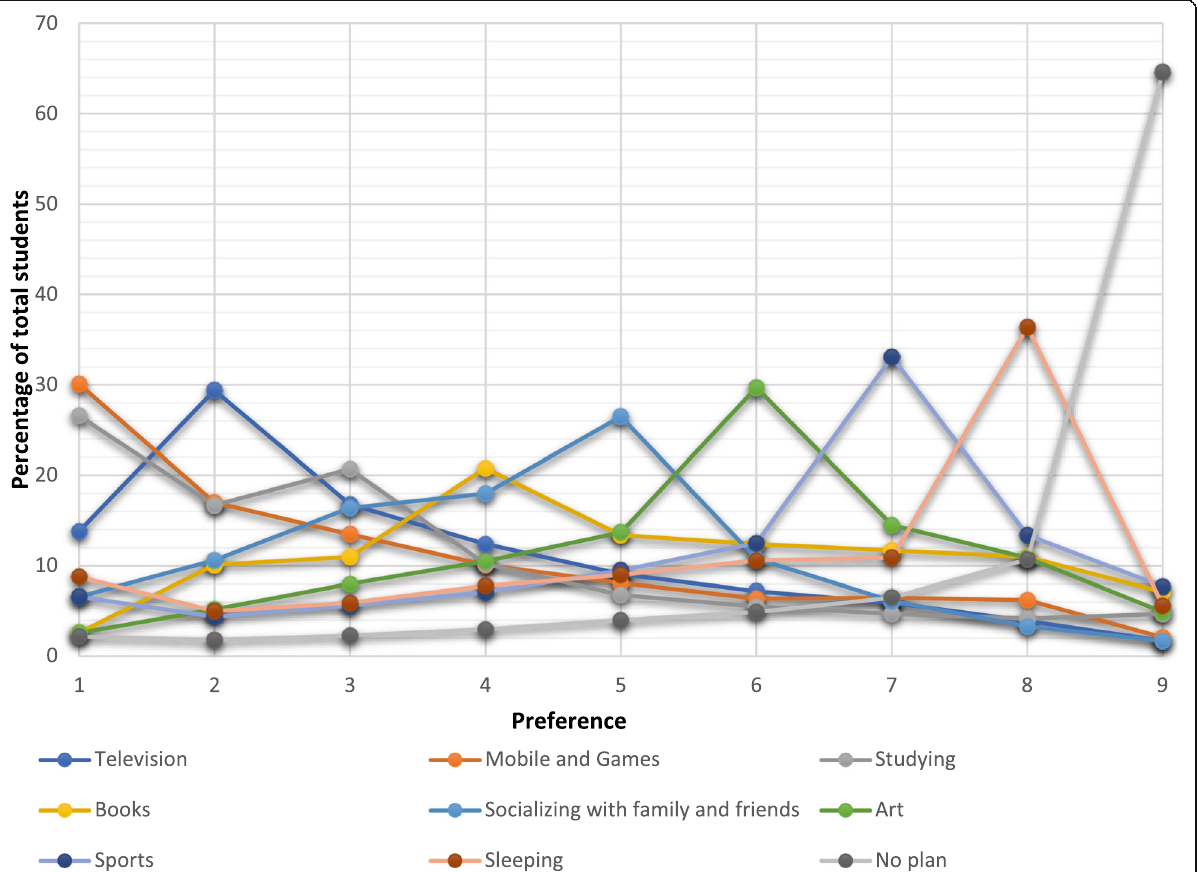
Fig. 2 The overall percentage of activity preference among students during the school